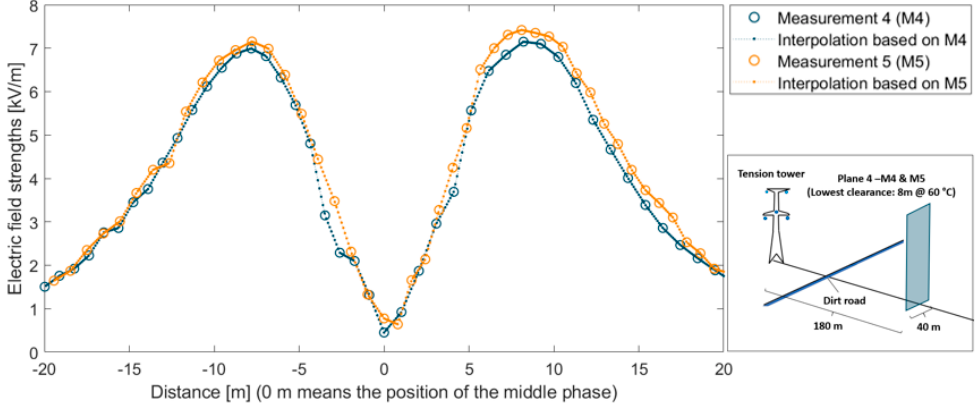
Figure 2. Measured electric field distribution at 1.8 m height above the ground (M4–M5). Table 2 summarizes the results of the electric field measurements. Table 2. Results of the electric field measurement. Measuring